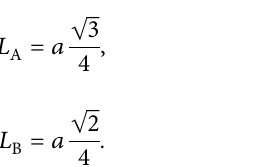
Figure 6: Variation of the (311) diffraction peak of Ni (c) 1000 °